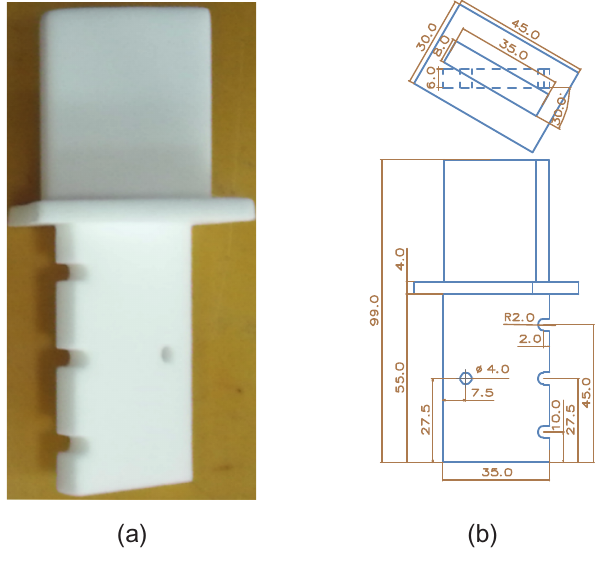
Figure 1: (a) The wax model and (b) size detail of the